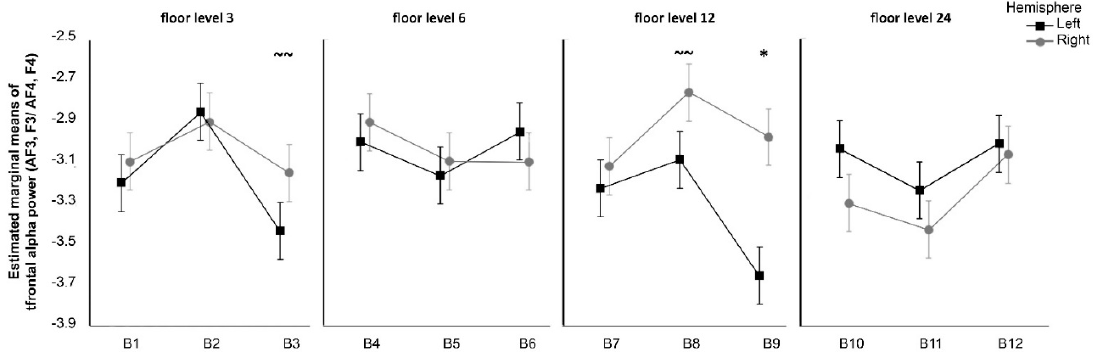
Figure 5. Differences in mean values between Hemisphere and Block for different floors. Significant differences ( p < 0.05): asterisks (*), trend towards significance (0.10 < p < 0.20): double tilde (~~). Error bars represent within subject standard error of the mean [51].